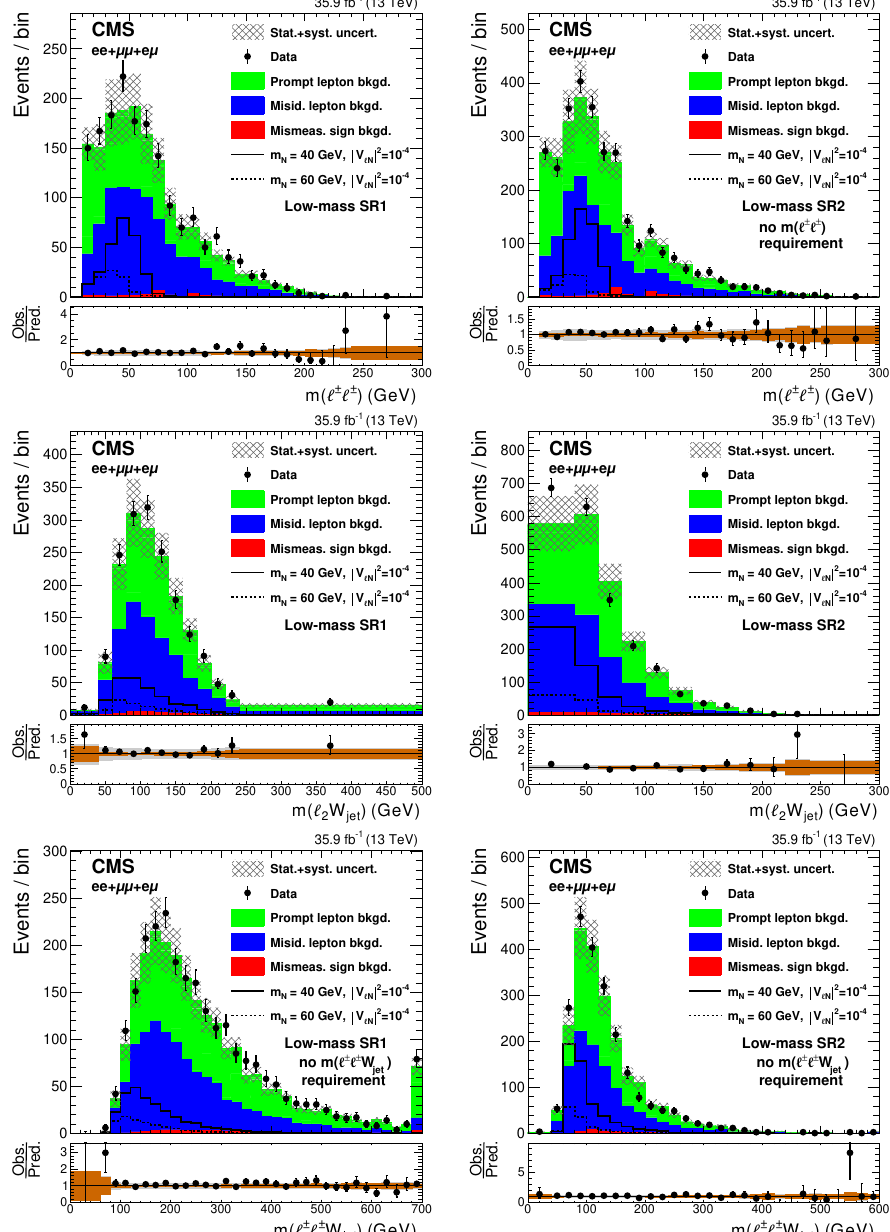
Figure 2 . Observed distributions of the invariant mass of the two leptons (upper), invariant mass of the subleading lepton and jets (middle), and the invariant mass of the reconstructed W propagator (lower), compared to the expected SM background contributions, for the low-mass SR1 (left) and SR2 (right), after combining the events in the ee, (cid:22)(cid:22) , and e (cid:22) channels. The hatched bands represent the sums in quadrature of the statistical and systematic uncertainties. The solid and dashed lines show the kinematic distributions of two possible signal hypotheses. The lower panels show the ratio between the observed and expected events in each bin, including the uncertainty bands that represent the statistical (brown) and total uncertainties